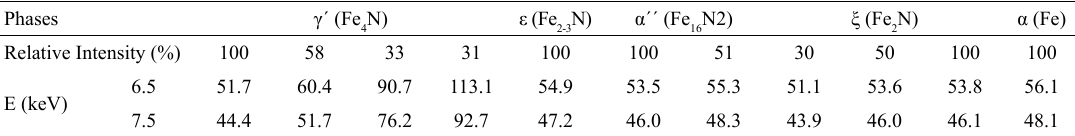
Table 5. Positions (°) of diffracted angles for iron nitrides.